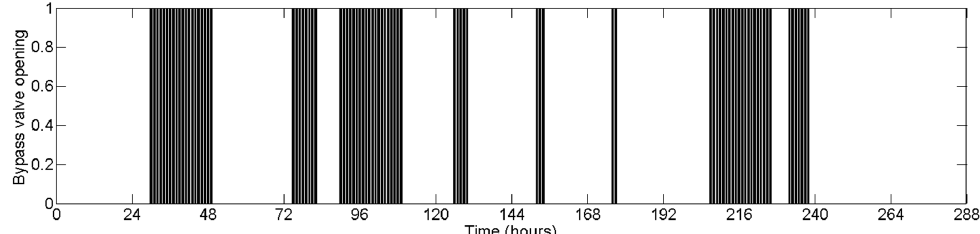
Figure 9. Operational scheduling for the bypass valve of the single NC 100–200 turbine installed at location 4.